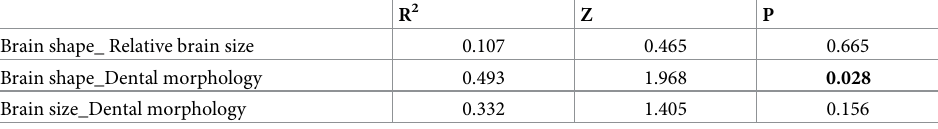
Table 4. Phylogenetic two-block least square analyses for integration in evolutionary rates between brain size and shape and dental